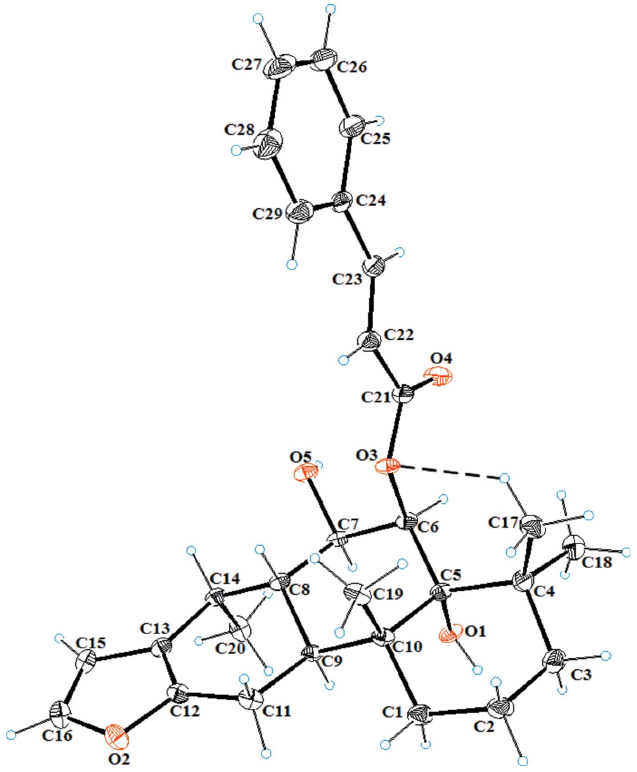
Figure 1 The molecular structures of the title compound, showing atom-labelling scheme with displacement ellipsoids drawn at the 50% probability level. The intramolecular C—H (cid:2)(cid:2)(cid:2) O interaction is shown as a dashed